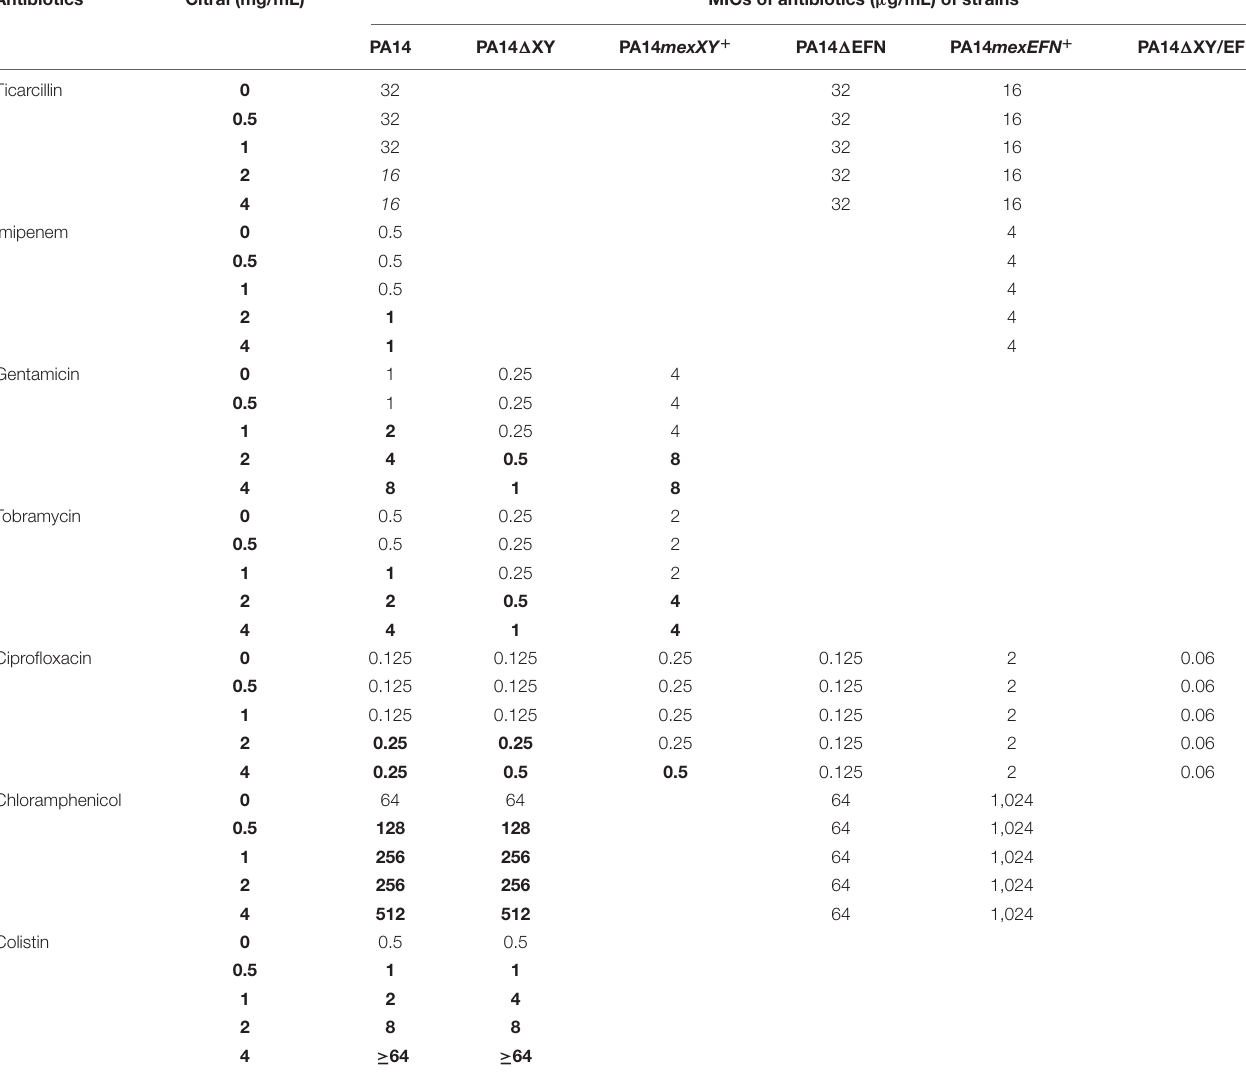
TABLE 1 | Influence of citral on P. aeruginosa susceptibility to antibiotics. Antibiotics a Citral